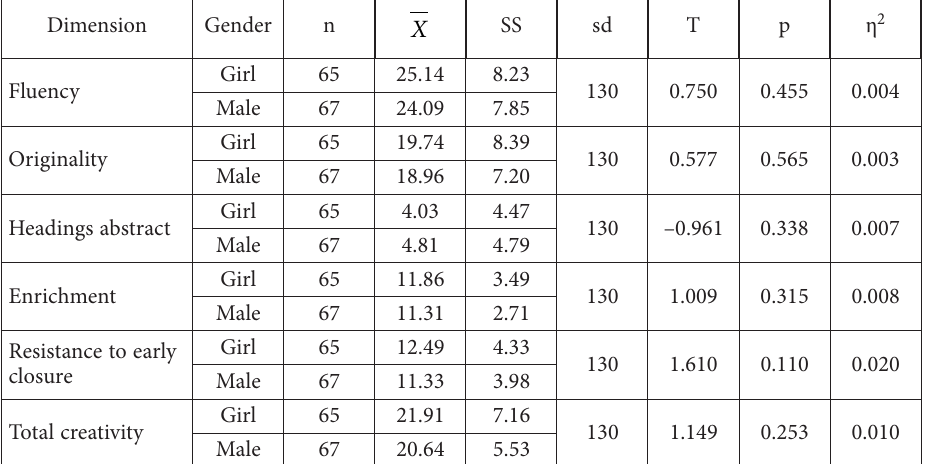
Table 7. Results of T-Test of creativity score of seventh grade children according to gender (souce: created by author)